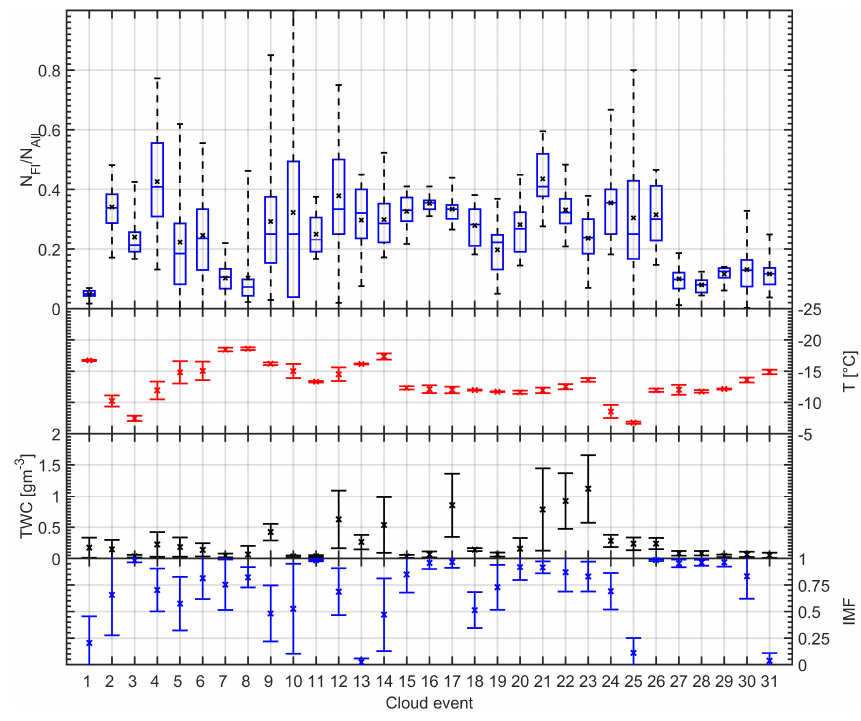
Figure 8. Box and whisker plots of fluorescent to total aerosol concentration ratio for cloud events persisting for at least 30min in duration with accompanying temperature, total water content, and ice mass fraction measurements. Box and whiskers denote 5th, 25th, 50th, 75th, and 95th percentiles; x marker denotes